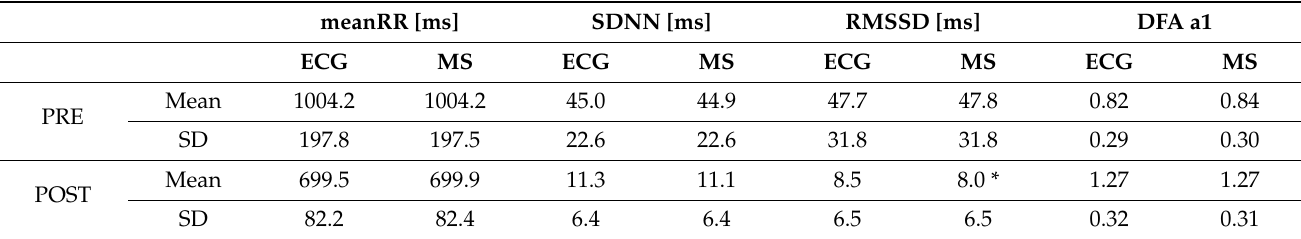
Table 1. Mean and standard deviation (SD) for the comparison of the 12 channel ECG (ECG) and the Movesense Medical sensor (MS) during PRE and POST the incremental exercise test for meanRR, SDNN, RMSSD, and DFA a1 during PRE and POST condition. * denotes statistical differences in comparison of the two devices with p <